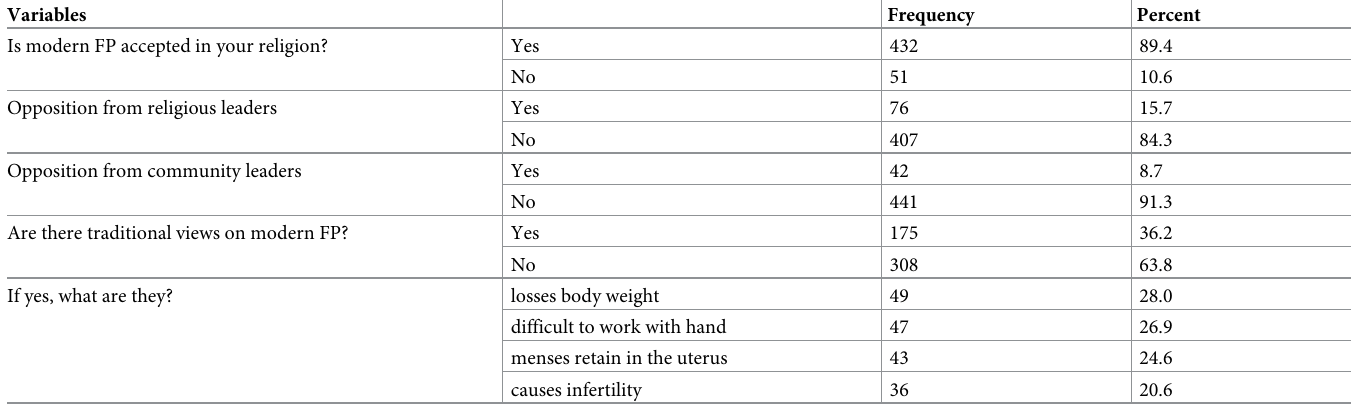
Table 5. Religious, cultural, and traditional related factors in South Gondar, Ethiopia, 2017 (n = 483). Variables